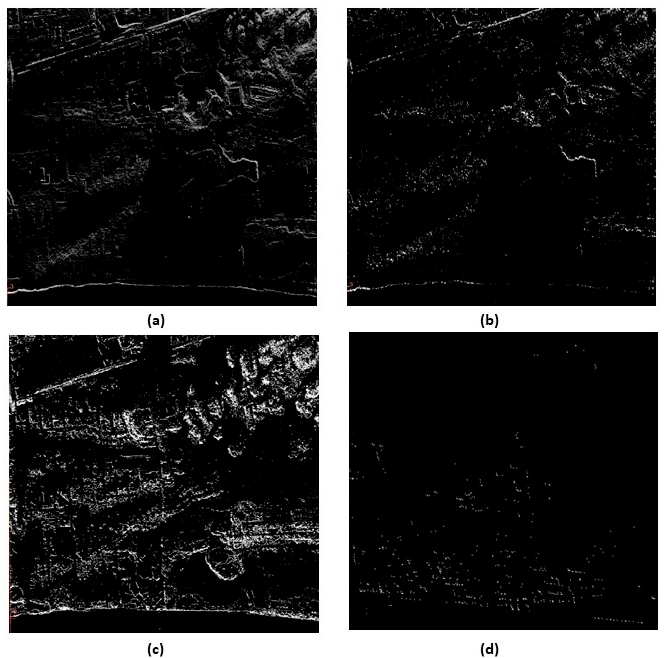
Figure 8. Simulated reflectivity maps over Area4: ( a ) All-reflections, ( b ) Double bounce, ( c ) Shadow, and ( d ) Layover.